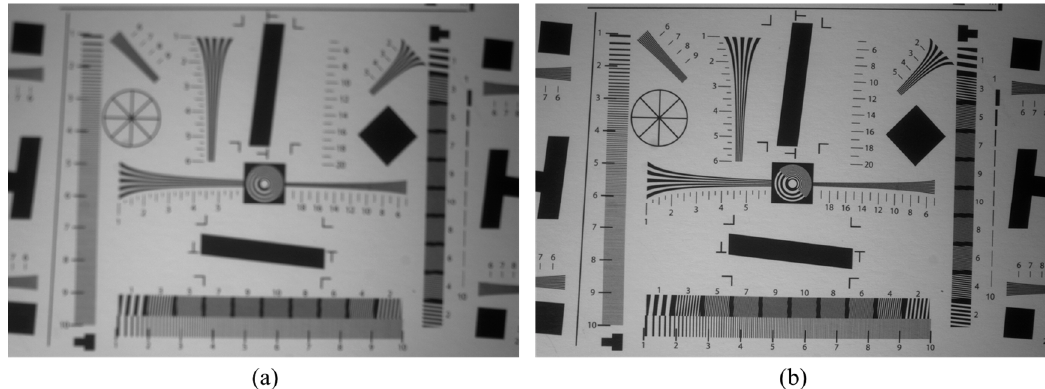
Figure 10. Recorded images when the LC lens is ( a ) turned off and ( b ) turned on.